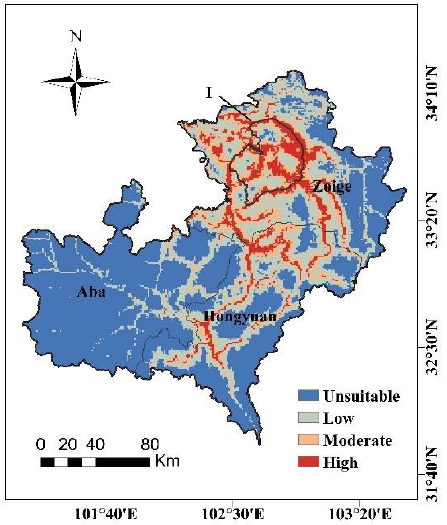
Figure 6. Map of the habitat suitability of black-necked crane in the Zoige Grassland Wetland National Key Ecological Function Zone (I. Zoige Wetland National Nature Reserve).